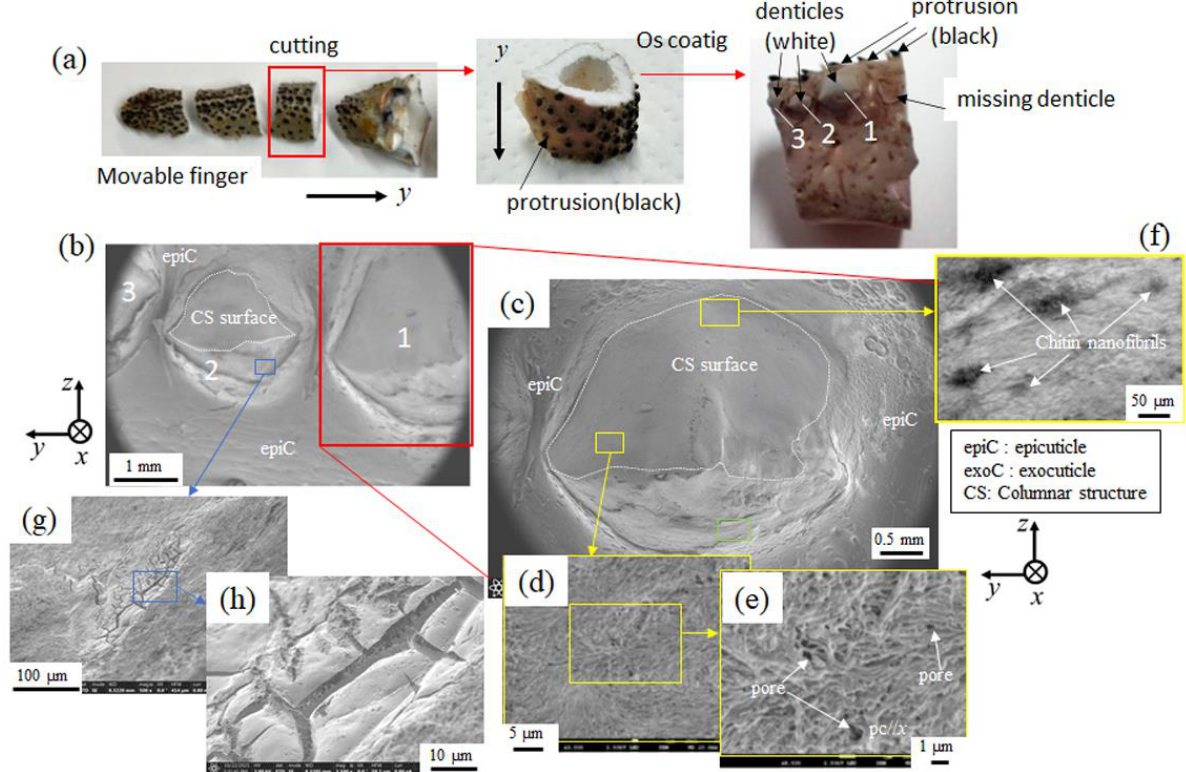
Figure 5. ( a ) Appearance of a sample after osmium coating and ( b , c ) SEM micrograph of the surface observed from the denticle top; ( d – f ) enlarged SEM micrographs of the area enclosed by yellow rectangles in ( c ); ( g , h ) enlarged SEM micrographs of the area enclosed by the blue rectangle in ( b ). The denticles, which exist only on the pinching side of the claw, come into direct contact with predators and prey, and a large force is applied to them locally when pinched. In particular, the force is concentrated at the top of the denticle. Hence, the exo- cuticle, and certainly the epicuticle near the top of many denticles, should be lost due to abrasion. The coconut crab in the present study weighed 1650 g; Figure 6 shows SEM im- ages of the denticle surfaces of claws of three coconut crabs weighing 1070 g, 610 g, and 300 g, which had been observed previously. The epicuticle and exocuticle were present on the columnar structure of the denticle in the 1070g coconut crab (Figure 6(a)), and in the 610 g coconut crab, only the exocuticle was observed on the denticle surface (Figure. 6(b)). However, these two layers were not found on the denticle surface of the 300 g coconut crab (Fig. 6(c)). This is consistent with the result shown in Figures. 1(d) and 2. The differ- ences in these results appear to be related to the denticles and positions we observed ra- ther than the size of the coconut crab. Figure 7 shows the results from observing the surface of the pinching side of the fixed finger shown in Figure 1(b) with OM and SEM. The very thin and soft epicuticle layer may peel off and disappear during polishing, but the mineralized exocuticle layer does not. As shown by the red line in Figure 7(b), the exocuticle layer was lost in the wide area above the large denticles; conversely, it could be observed in the surface of the relatively small denticles and in the base (i.e., the valley) of the denticle. The SEM micrograph of the den- ticle surface without the thin layers shown in Figure 7(c) agrees with that shown in